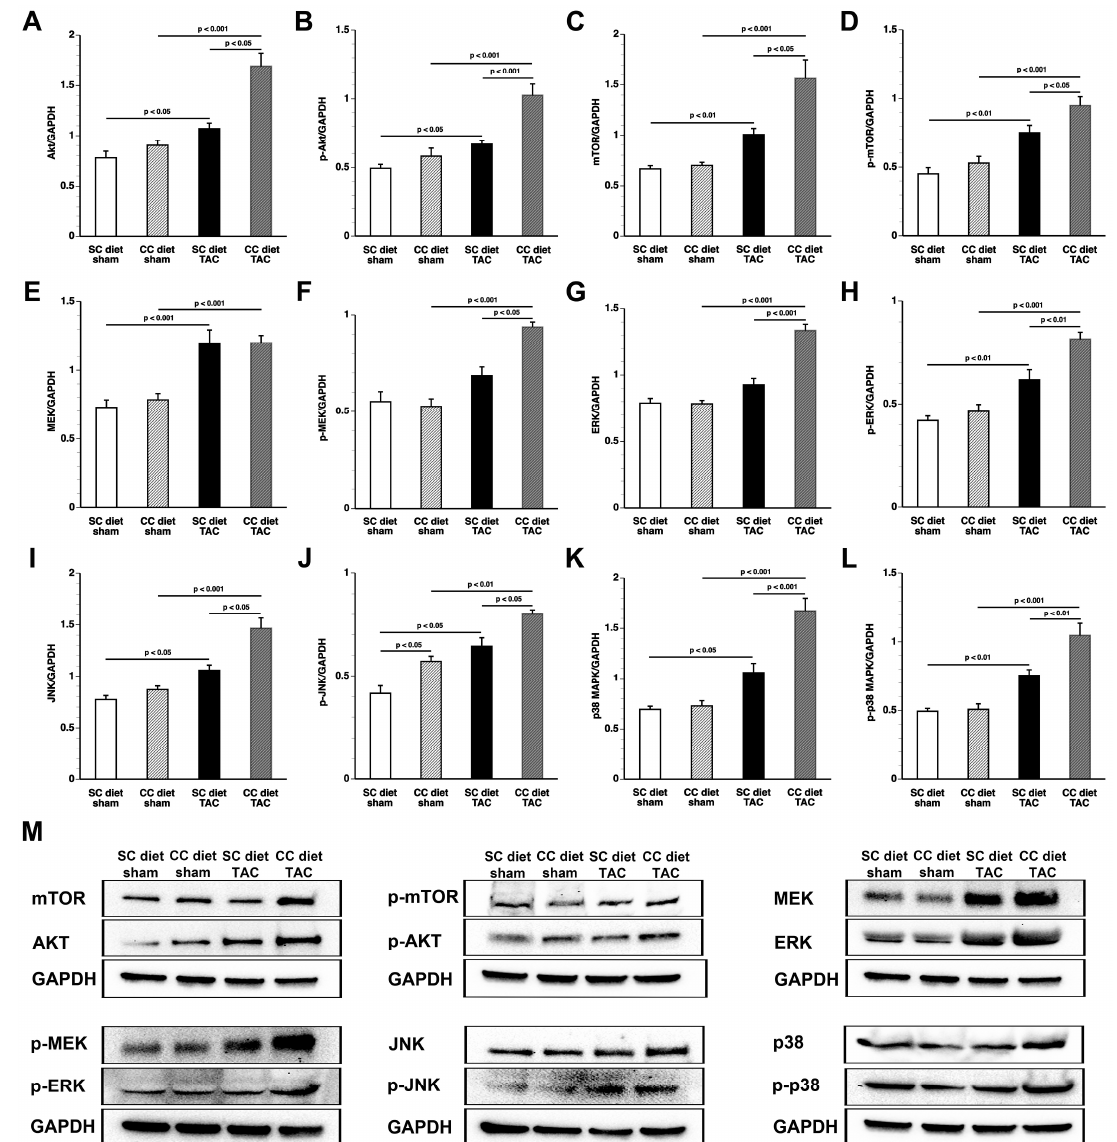
Figure 4. Quantification of pro-hypertrophic myocardial proteins by Western blot. Intensities of immunoreactive bands on Western blots were quantified by densitometric analysis. Bar graphs illustrating: Akt ( A ); p-Akt ( B ); mTOR ( C ); p-mTOR ( D ); MEK ( E ); p-MEK ( F ); ERK ( G ); p-ERK ( H ); JNK ( I ); p-JNK ( J ); p38 ( K ); and p-p38 ( L ) protein levels quantified by Western blot in the myocardium of SC diet sham ( n = 10), CC diet sham ( n = 10), SC diet TAC ( n = 10), and CC diet TAC ( n = 10) mice eight weeks after operation. All protein levels were normalized to the glyceraldehyde-3-phosphate dehydrogenase (GAPDH) protein level. Representative images of Western blots are shown in panel ( M ).